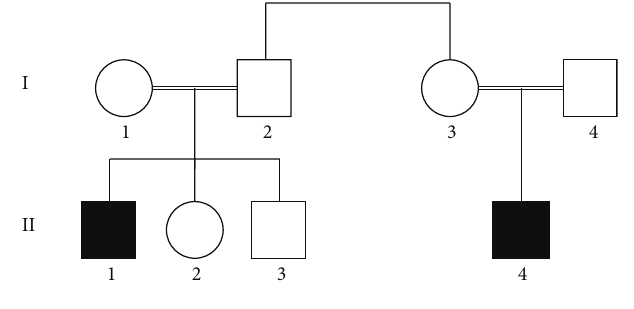
Figure 2: Pedigree of Family